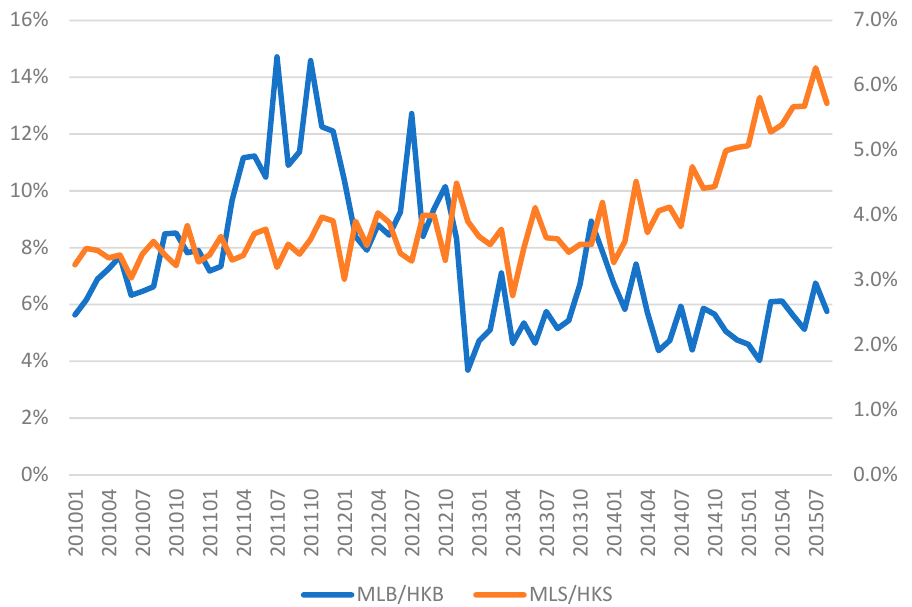
Figure 4. Proportions of Transactions of Non-local to Local Buyers and Sellers. Notes: the proportion of transactions of non-local buyers to local buyers (MLB/HKB)—left axis, the proportion of transactions of non-local sellers to local sellers (MLS/HKS)—right axis.